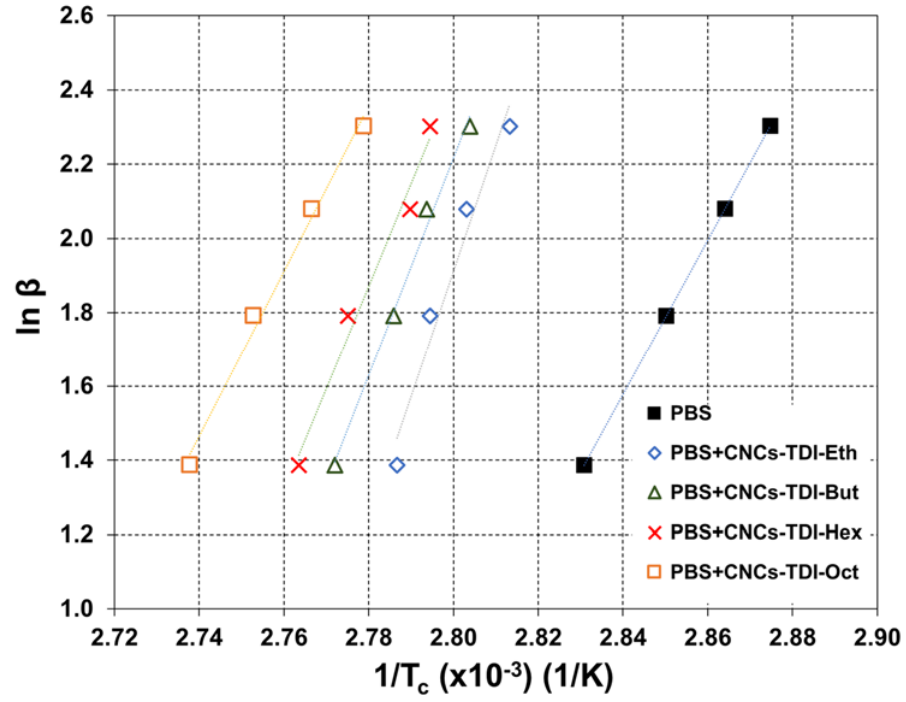
Figure 6. Kissinger plot to determine the activation energy of crystallization of neat and reinforced PBS.